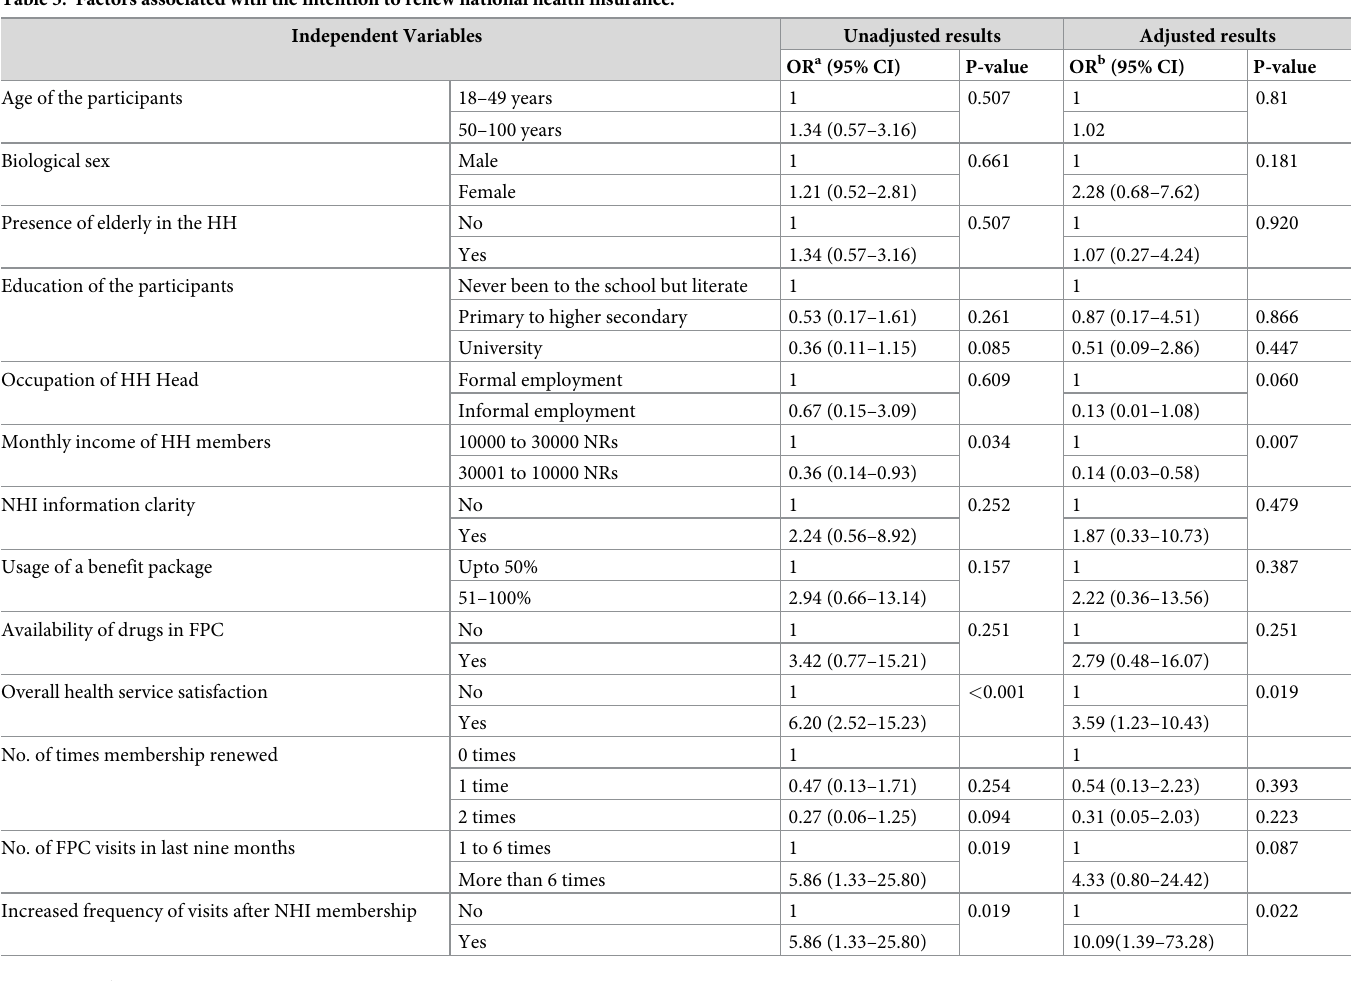
Table 3. Factors associated with the intention to renew national health